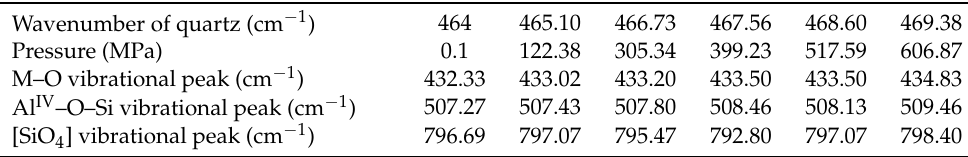
Table 2. Raman spectra data of colorless orthoclase at different